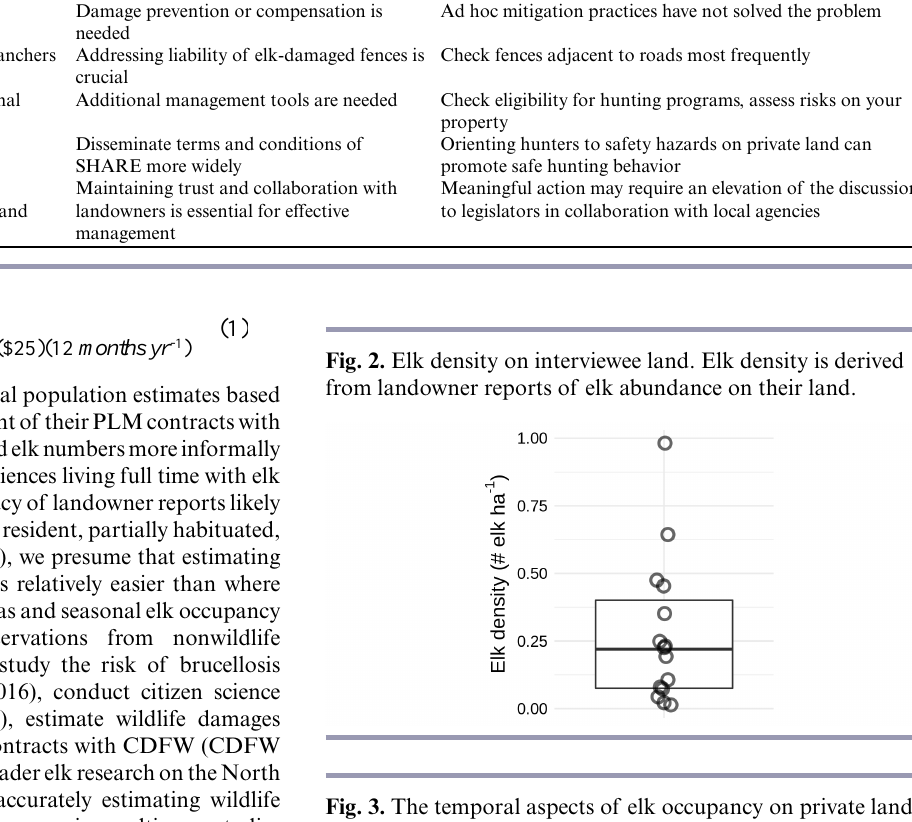
Fig. 3. The temporal aspects of elk occupancy on private land. This includes both the fraction of the year that elk are in the vicinity of the private holding (y axis; F1 in Eq. 1) and the fraction of time elk spend on the private holding within times of the year that they are seasonally present (x axis; F2 in Eq. 1). Symbol size is proportional to elk